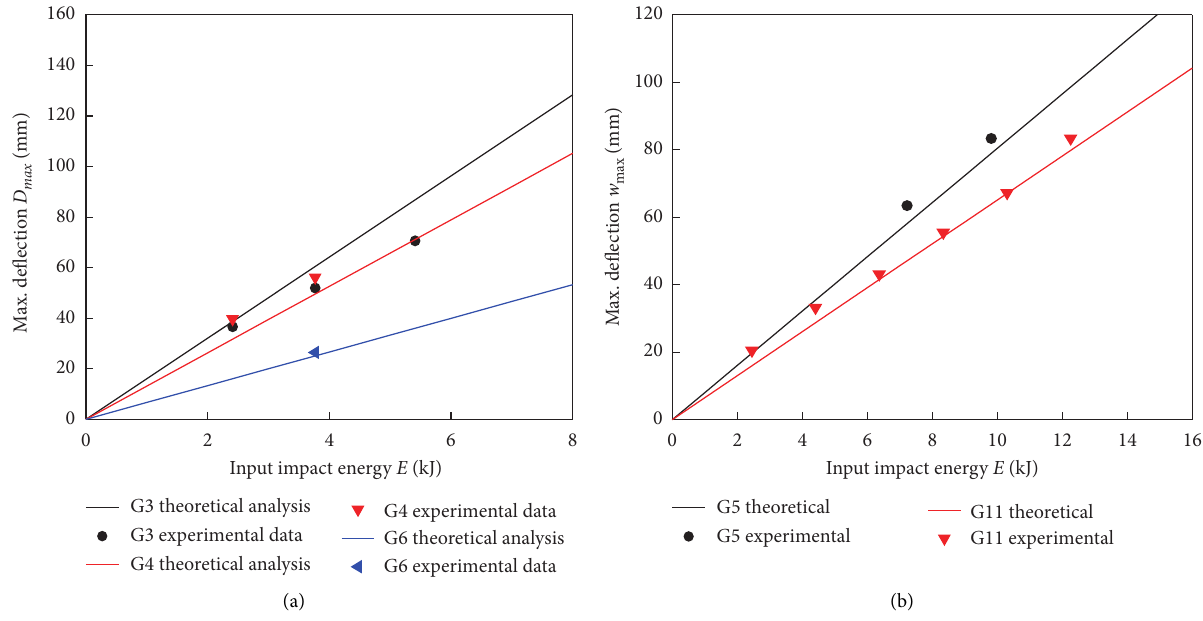
Figure 13: Comparison between the theoretical results and Kishi’s experiments for simply supported RC beams in detail. (a) Series G3, G4, and G6. (b) Series G5 and G11.